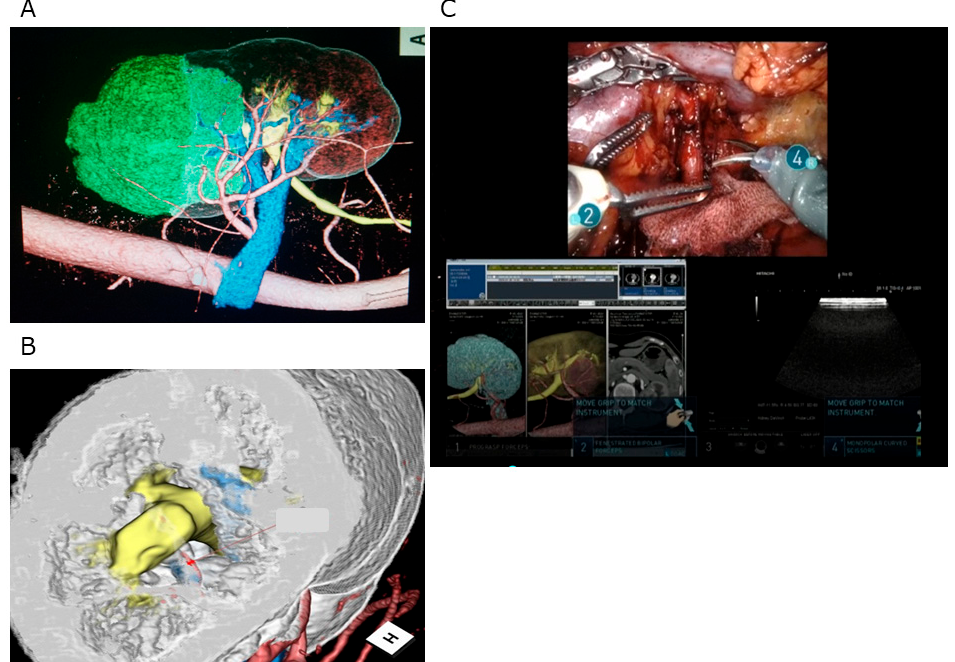
Figure 3. Intraoperative navigation system using ultra-high-resolution computed tomography. ( A ) Image of the tumor, urinary tract, and vascular structures, including the renal pedicle. ( B ) Preoperative image of the cut surface of the tumor. ( C ) Intraoperative navigation system using TilePro software. ( A ) and ( B ) show the same renal tumor; ( C ) shows another renal tumor.